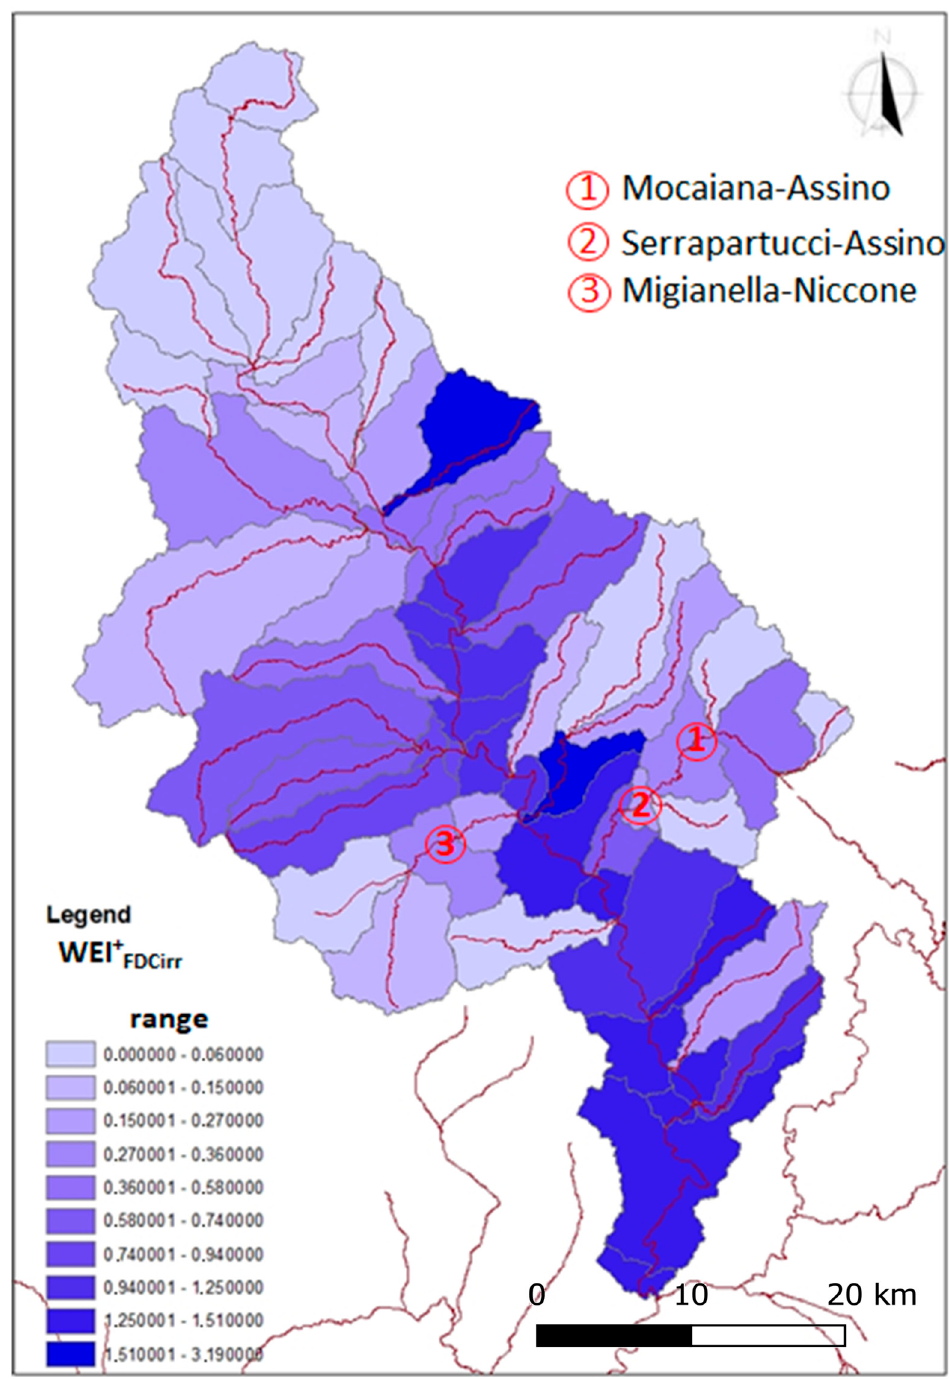
+ irr in the Upper Tiber River